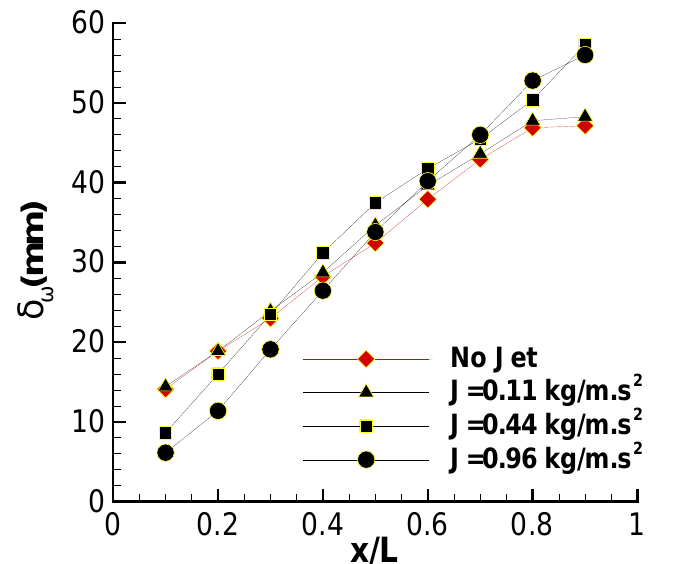
Figure 8. The vorticity thickness of the cavity separated shear layer along x -axis for Re D ≈ 50,000; sharp edge at LE; different J